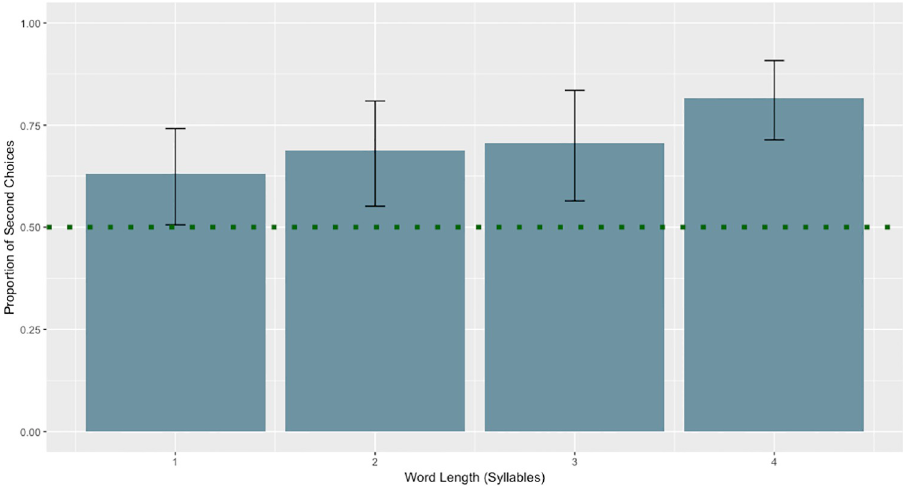
Fig 6. Bias is stronger when choice options have more syllables. Proportion of second choices made separated by word length. Dotted line indicates chance. For words two syllables or more, the proportion of second choice selections is significantly above